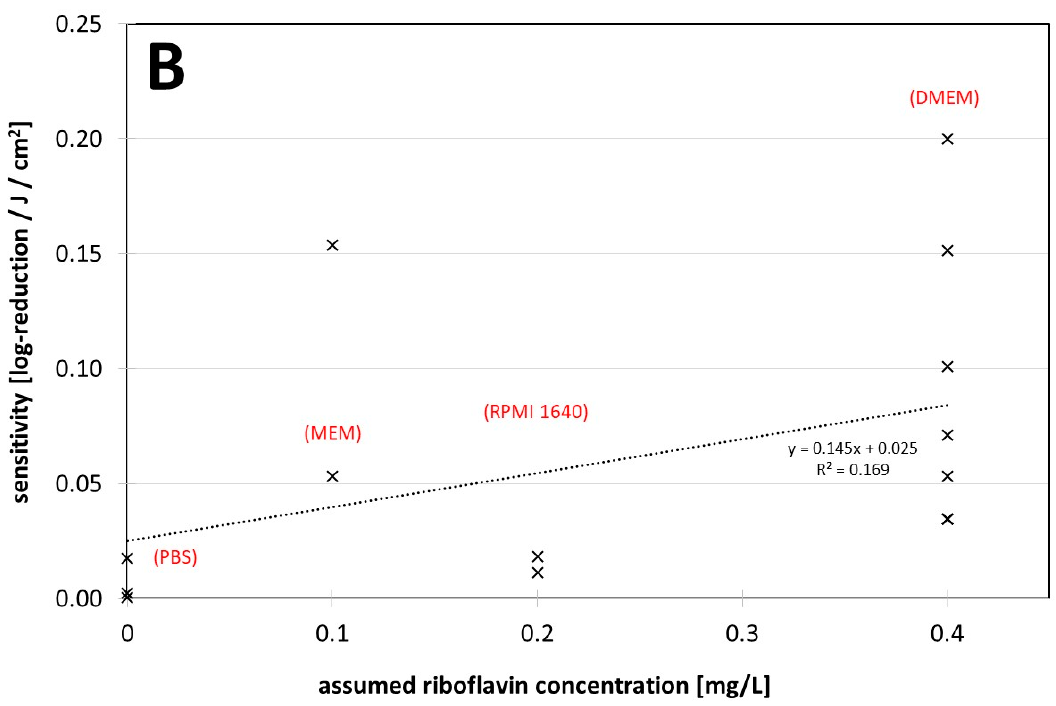
Figure 2. ( A ) Visible light sensitivity (inverse of the log-reduction dose) for viruses in different assumed riboflavin concentrations (media) for the non-enveloped viruses. ( B ) Visible light sensitivity for viruses in different assumed riboflavin concentrations (media) for enveloped viruses including coronaviruses. The dotted lines were derived by linear regression and are meant to visualize the dependence between riboflavin concentration (medium) and observed virus